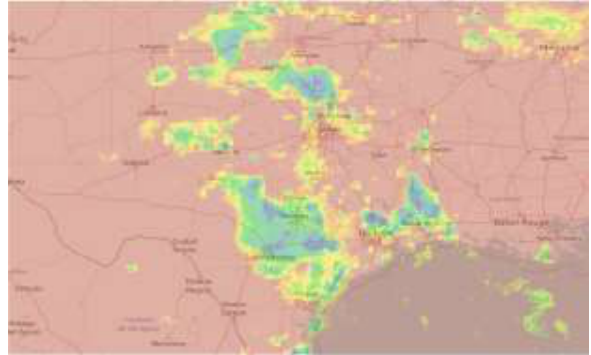
Figure 1. Data set from HRRR: composite reflectivity from June 2, 2016, 1200 GMT